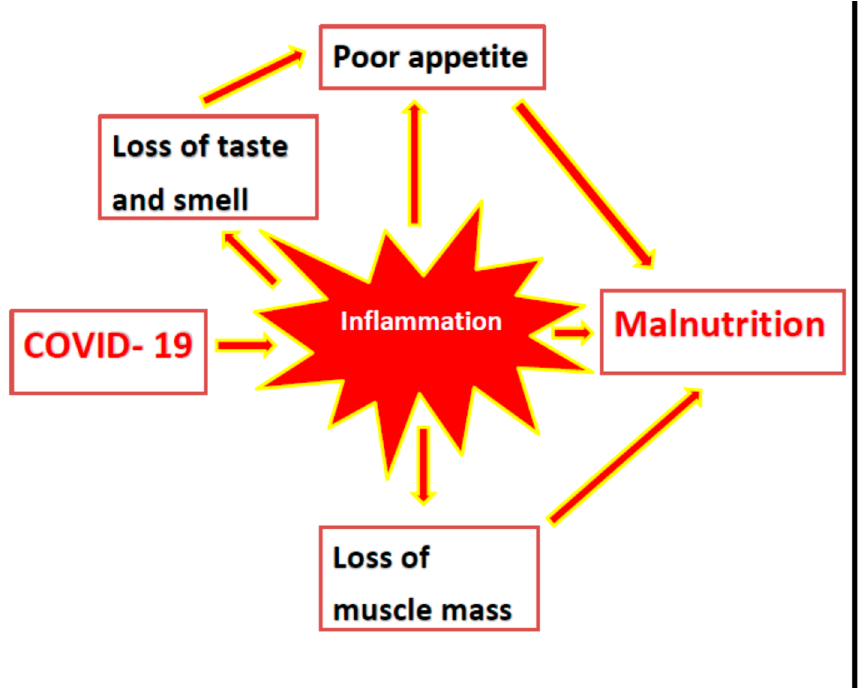
Figure 1. Risk factors for malnutrition that are related to the novel severe acute respiratory syndrome coronavirus (COVID-19).